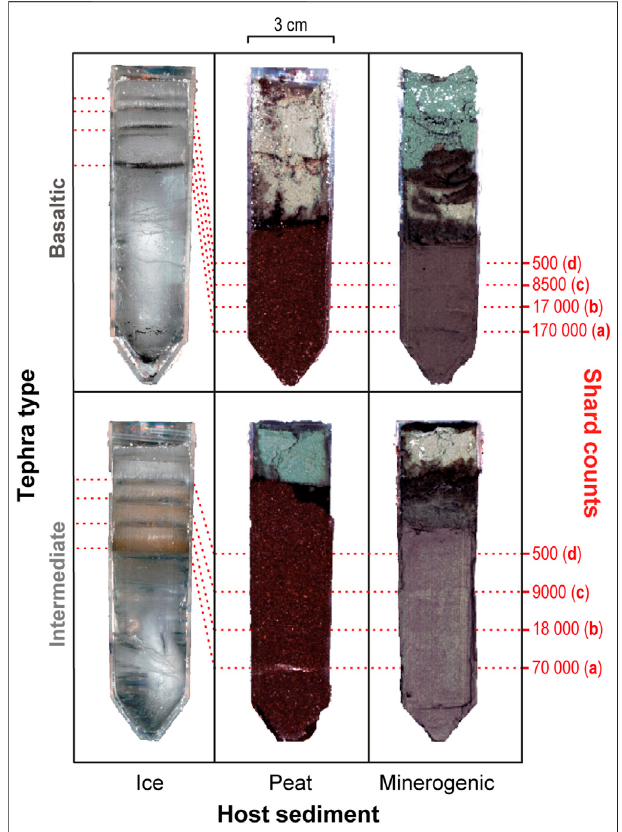
FIGURE 1 | Overview of the synthetic sediment cores (phantoms) createdfor this study in50 ml centrifuge tubes, organized per glass type (row) and host sediment (column). The position, shard counts and names (A – D) of the four glass shard horizons added to each core are highlighted in red on the